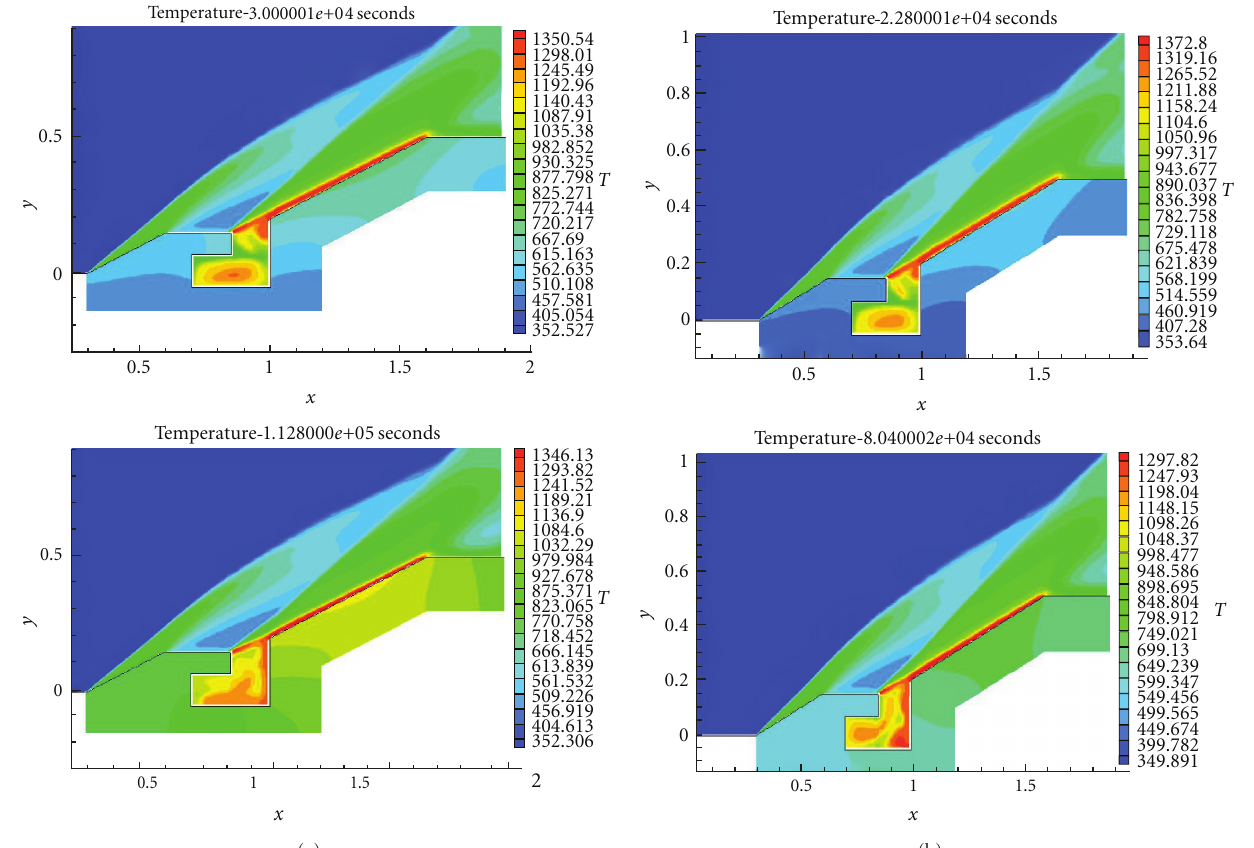
Figure 7: Temperature evolution inside and around a flap without (a) and with (b) radiation e ff